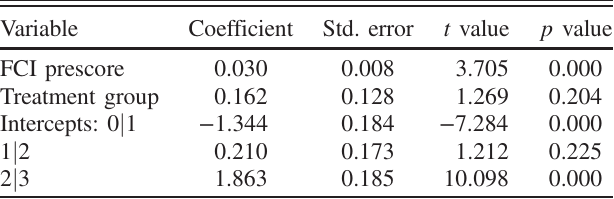
TABLE IV. Results of an ordered logistic regression model of rubric score versus FCI prescore and